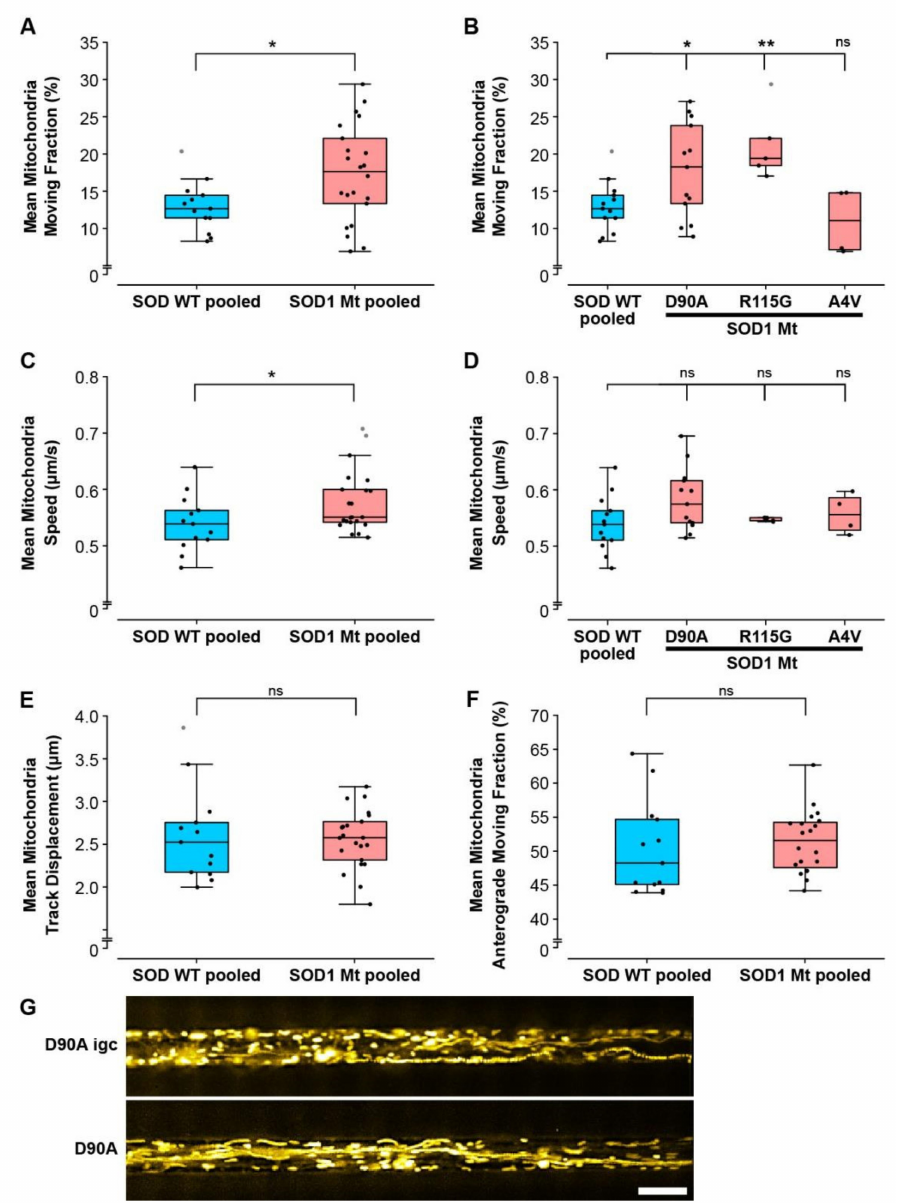
Figure 5. Altered motility of mitochondria in mutant SOD1 spinal MNs. ( A – F ) Box plots of various tracking parameters deduced from moving mitochondria as mean values per experiment (black dots) for each respective line with 25–75% interquartile range (box), median (horizontal line), non-outlier range (1.5-fold interquartile range added above and below to box, whiskers) and outliers (grey dots outside whiskers). SOD Wt pooled: data from all SOD Wt lines including D90A igc ( n = 6) were pooled ( n = 13) as listed in Table 1. SOD Mt pooled: data from D90A ( n = 13), R115G ( n = 4), and A4V ( n = 4) (Table 1) were pooled ( n = 21). Asterisks: highly significant increase in pairwise comparison of control cells (in blue) with mutant lines (in red), respectively, unpaired two-tailed Student’s t -test ( A , C , E , F ) or one-way ANOVA with Bonferroni post-hoc test ( B , D ). * p < 0.05, ** p < 0.01, n.s. not significant. ( A ) The percentage of moving mitochondria was increased in SOD1 Mt compared to SOD Wt pooled lines. ( B ) Comparison of single lines showed significantly higher percentages of moving mitochondria in D90A and R115G, but not in A4V. ( C ) Mean speed was significantly increased in pooled SOD1 Mt over Wt cells but single line comparisons ( D ) revealed no significant